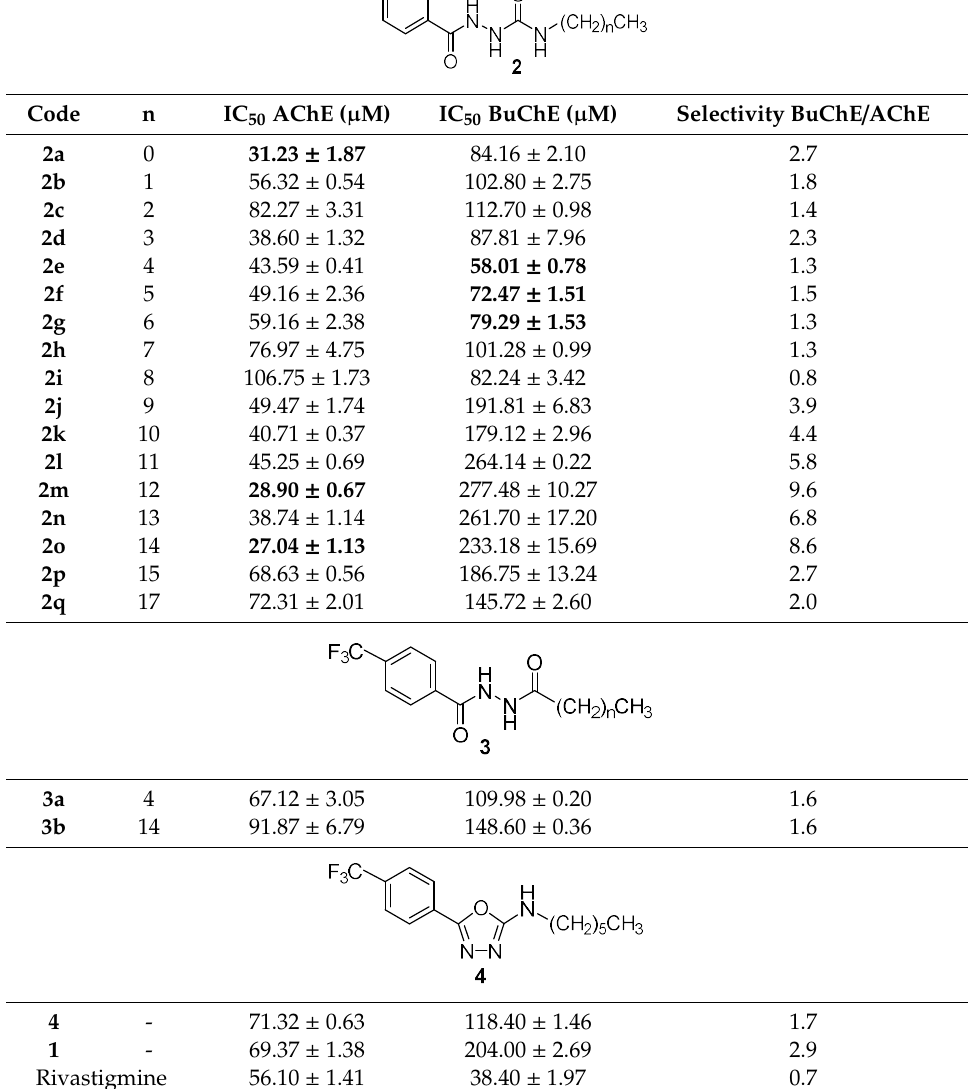
Table 1. IC 50 values for AChE and BuChE.